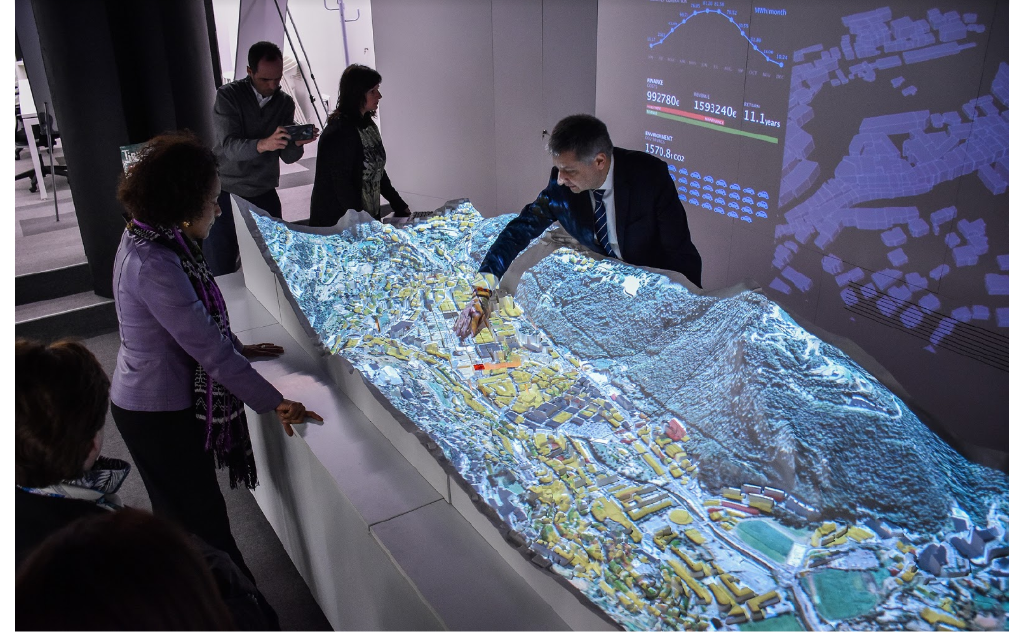
Figure 3. Discussion about the Andorra 3D city model between the Minister of Economy, Innovation and Competitiveness and the Ambassador of La